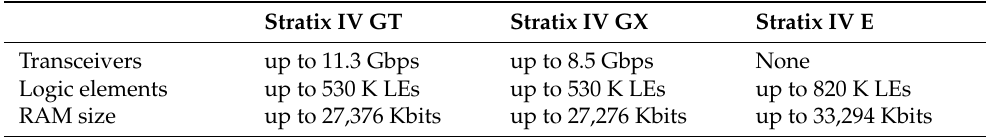
Table 1. Features of Stratix IV series.